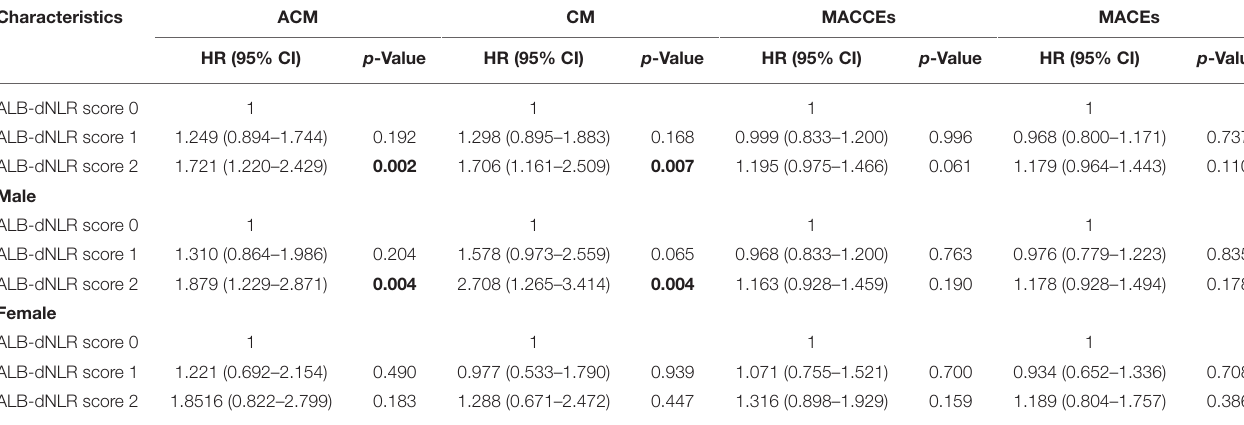
TABLE 4 | Univariate logistic regression analysis of ACM, cardiac death, MACCEs, and MACEs.